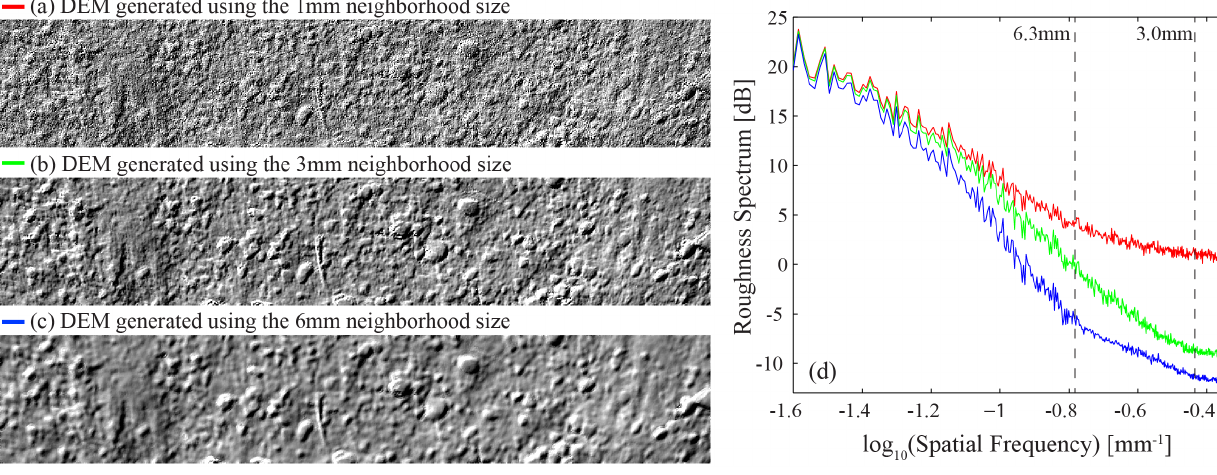
Figure 5. DEMs interpolated from all four scans and using three different neighborhood settings ( a – c ) and the mean roughness spectra estimated from these three DEMs ( d